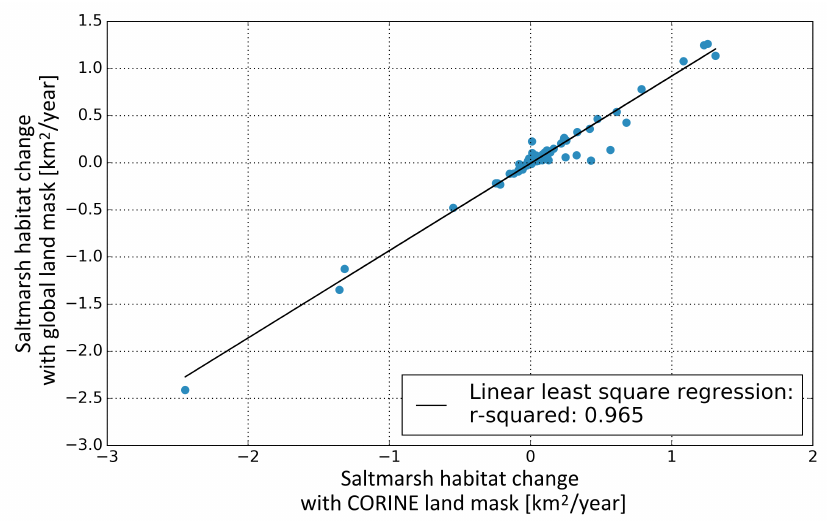
Figure A4. Correlation between saltmarsh trends (km 2 /year) resulting from DT classification using CORINE data set as land mask (European land mask solution) on the x -axis and relative saltmarsh trends resulting from DT classification using the produced global land mask (global land mask solution) on the y